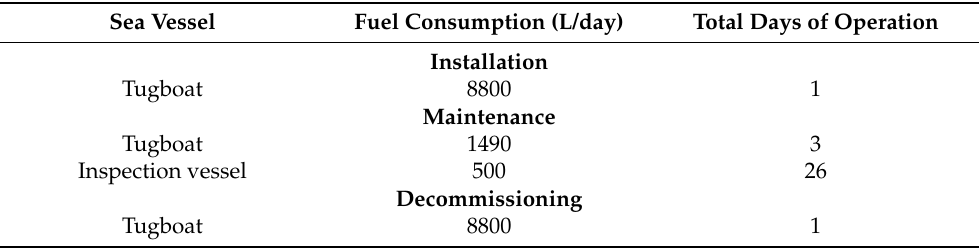
Table 3. Sea vessel operations over device’s